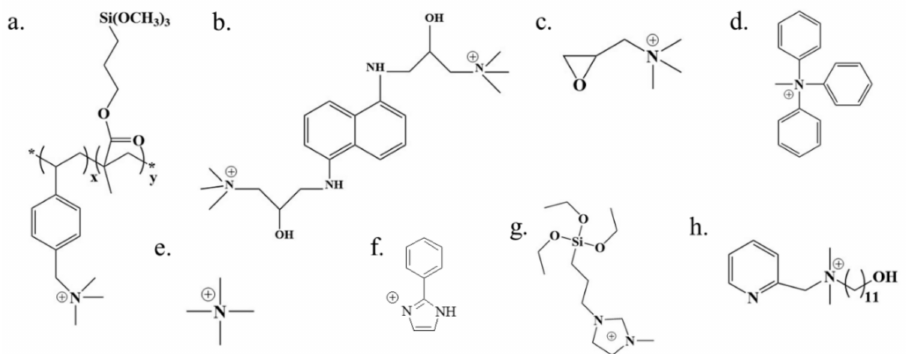
Figure 7. The structure of ( a ) quaternizated poly(VBC-co- γ -MPS), ( b ) Q-DAN, ( c ) glycidyl trimethyl ammonium chloride, ( d ) quaternary aromatic amine groups, ( e ) quaternary ammonium, ( f ) phenyl imidazole, ( g ) AESP ( h ) QUDAP [49,78,83,84,99–102].